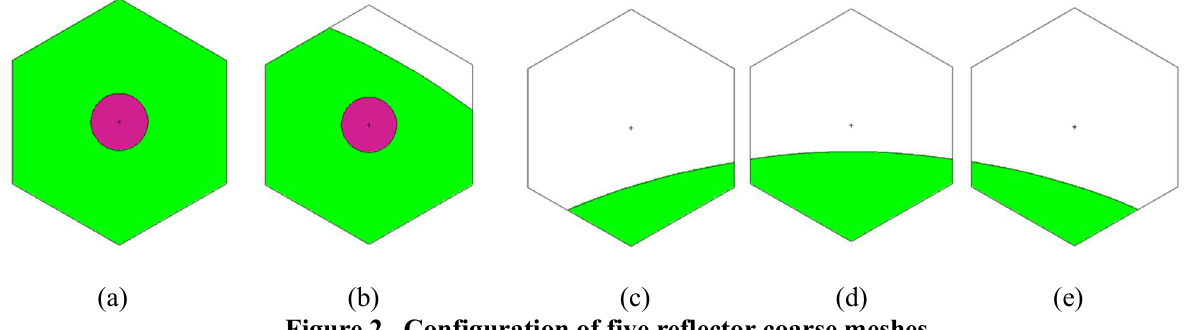
Figure 2. Configuration of five reflector coarse